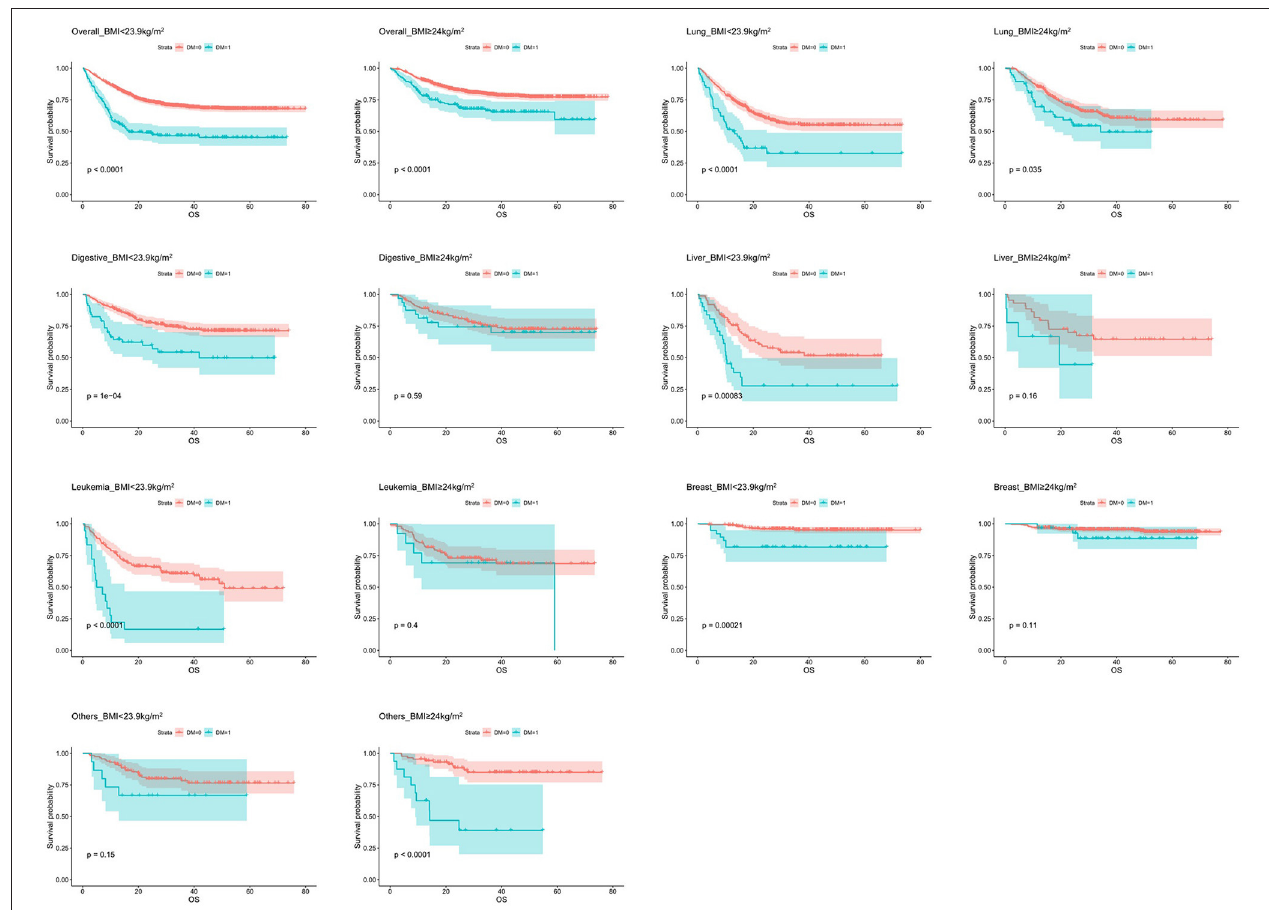
FIGURE 2 | Kaplan–Meier curves of overall survival in different cancer types stratified by BMI.